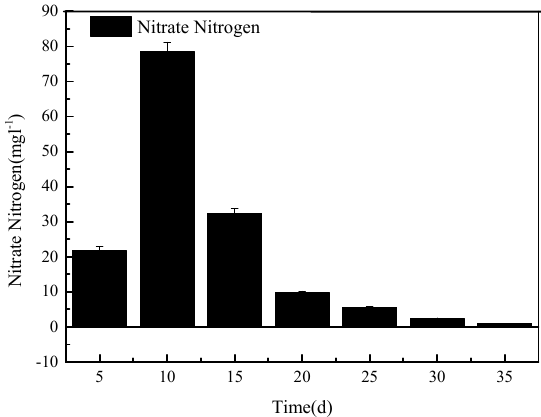
Figure 3. The concentration of nitrate determined at outlet 5 over 35 min of initial operation. The first sample was taken 5 min after outlet 5 was opened.